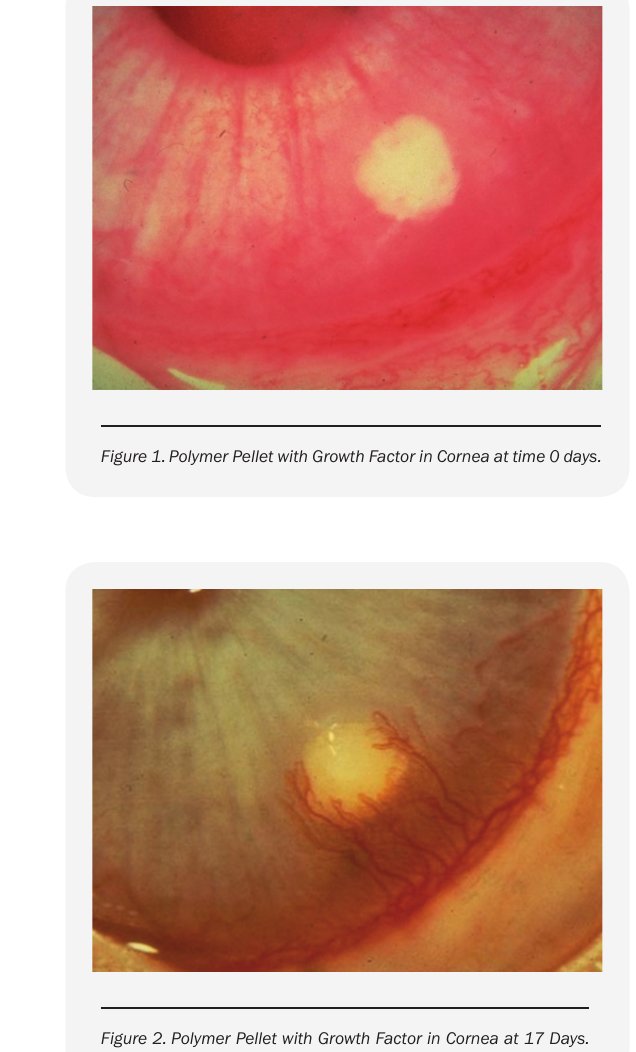
Figure 2. Polymer Pellet with Growth Factor in Cornea at 17 Days.